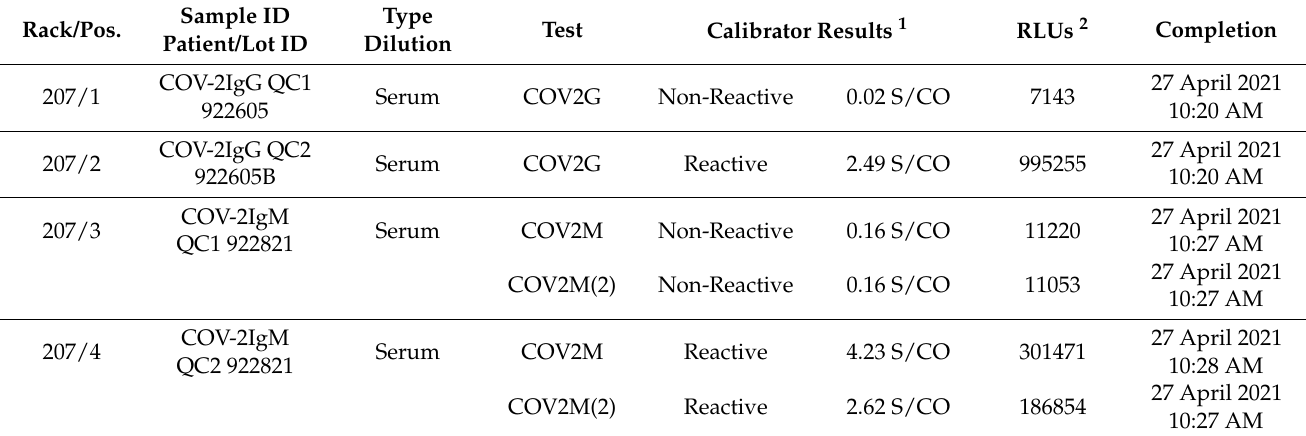
Table 3. Quality control for DXI600 analysis of